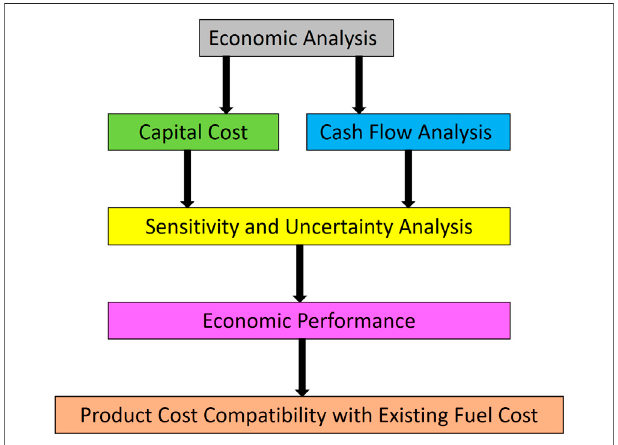
FIGURE 2 | Methodology fl ow chart of economic analysis.